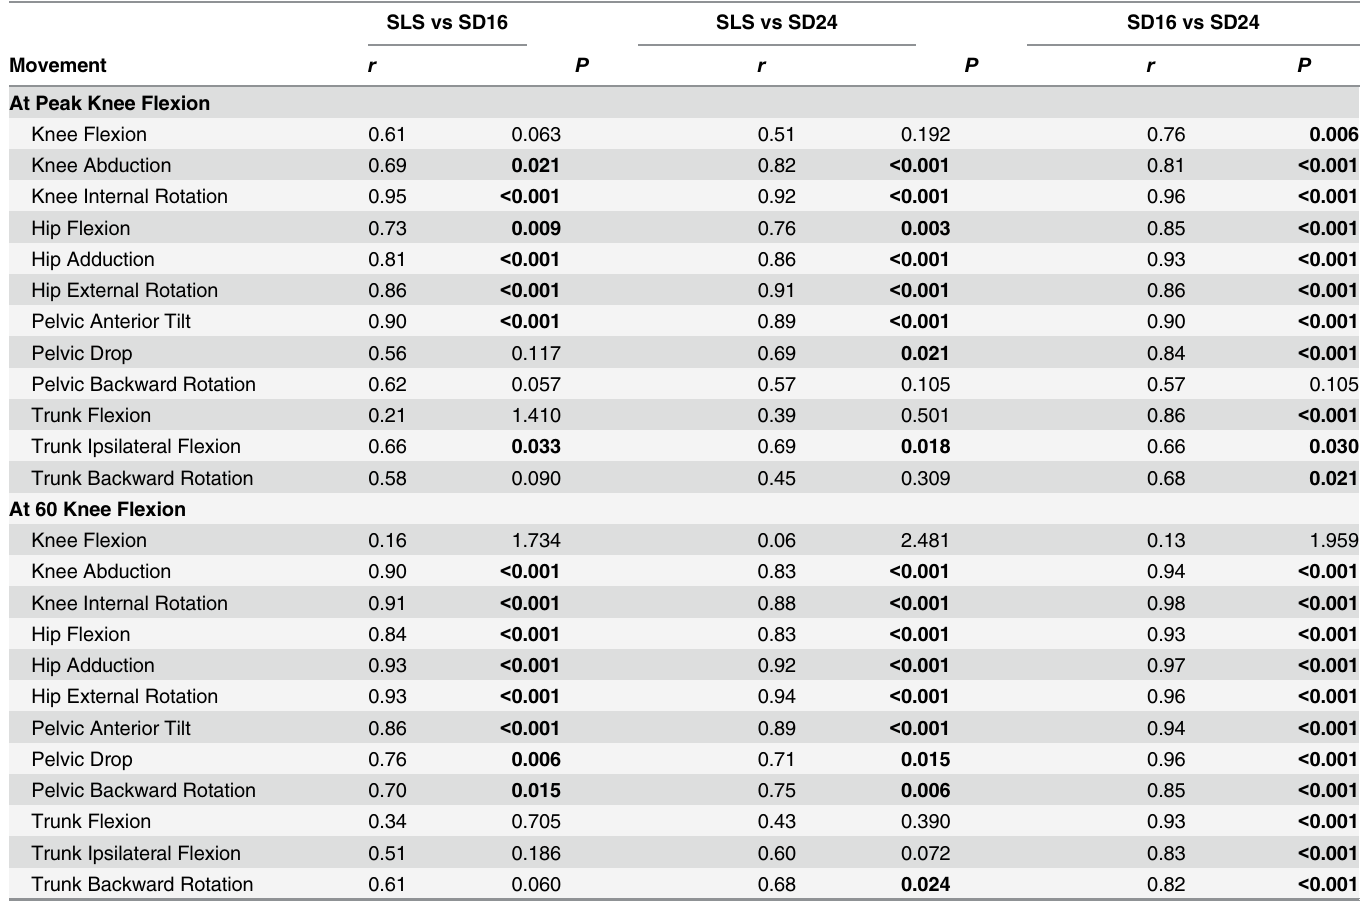
Table 3. Pearson correlation coefficients (r) for each variable for each comparison at the two time points are presented with bold text indicating